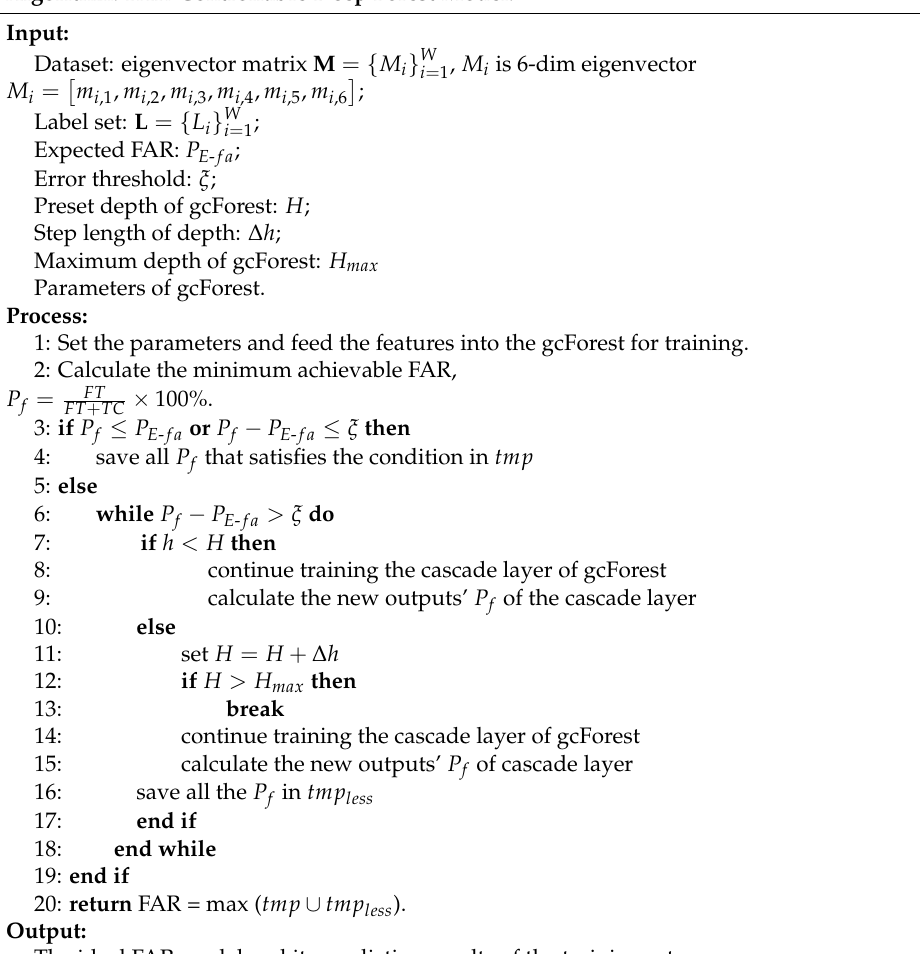
Table 4. Pseudo-code of false alarm rate (FAR)-controllable deep forest model. Algorithm: FAR-Controllable Deep Forest